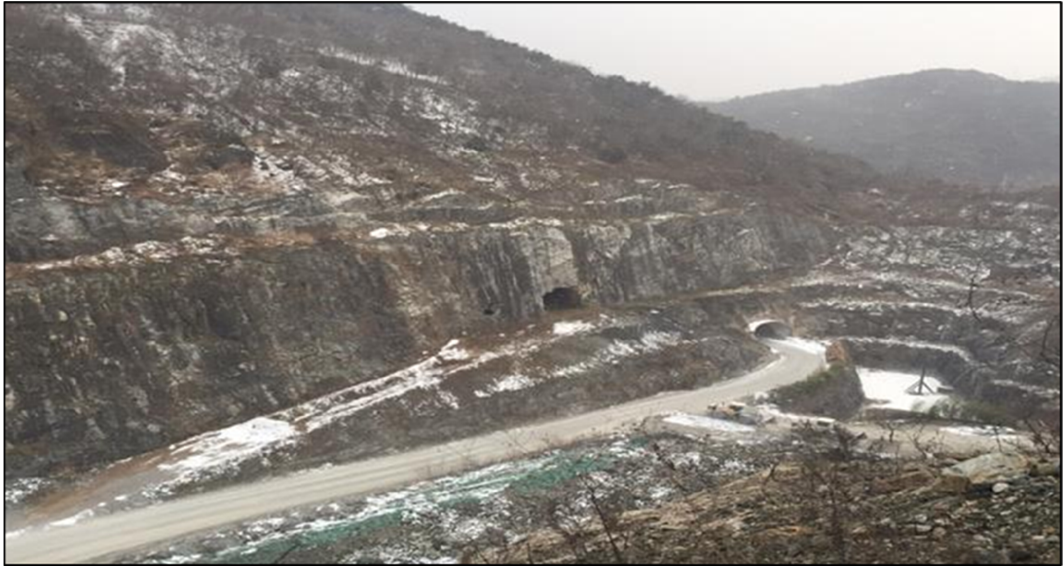
Figure 3. A view of the Gun-dong mine entrance and storage reservoir.